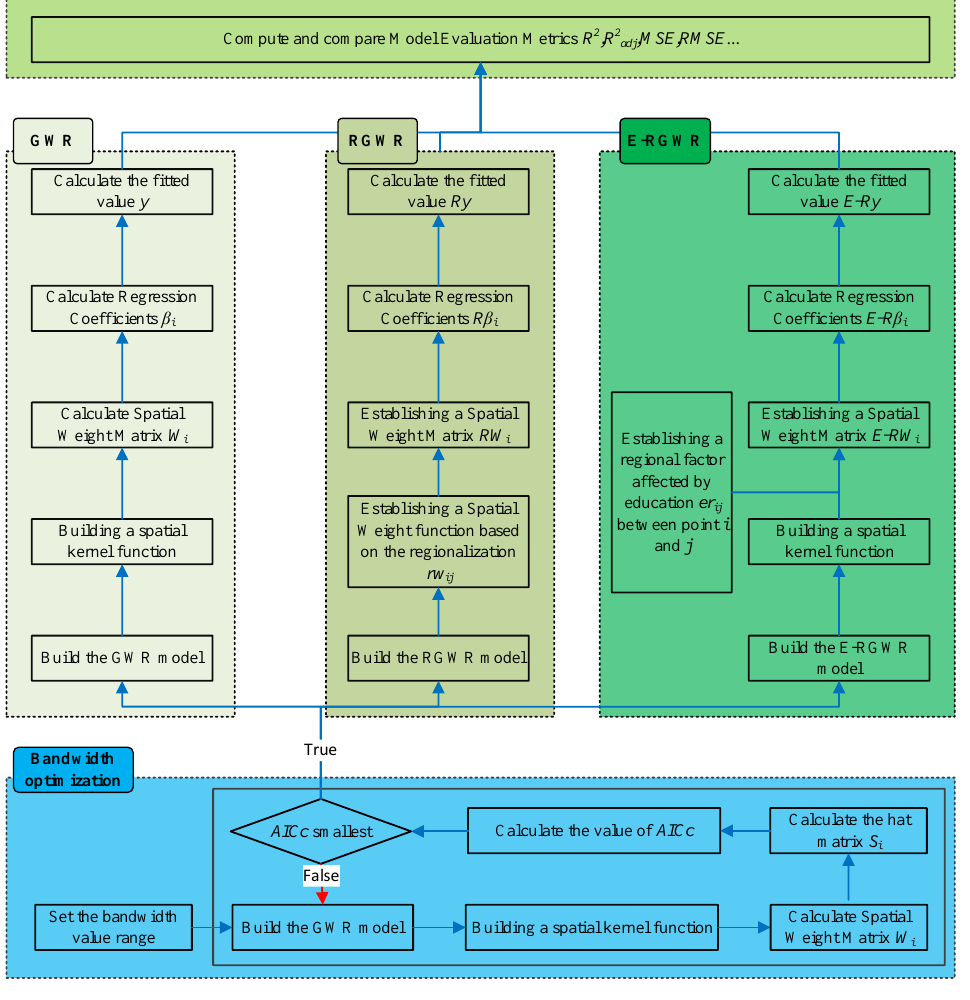
Figure 3. Analytical framework of the modeling methods used. The data include independent variables, dependent variables, spatial location varia- bles, education quality variables, and alternative bandwidth. The pseudo-code of E-RGWR is presented in Algorithm 1.